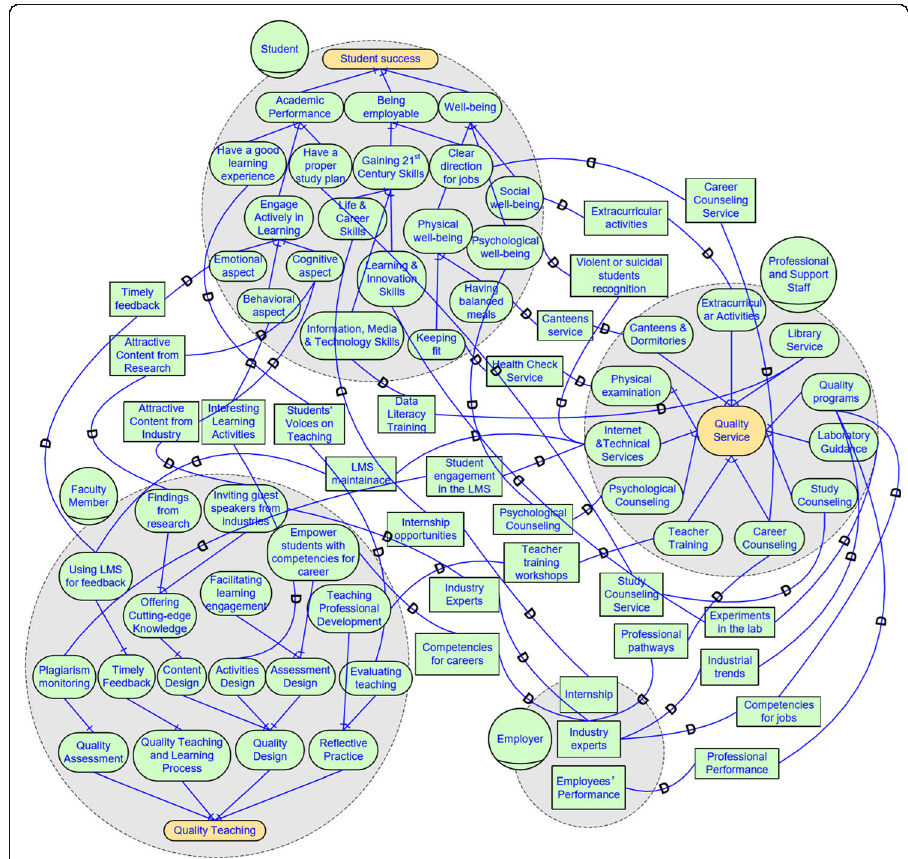
Fig. 3 A goal-oriented analysis of definitive stakeholders for student